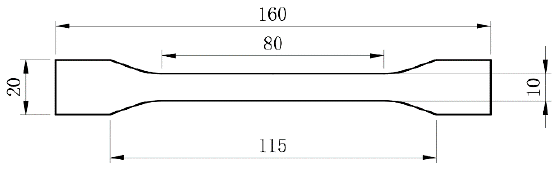
Figure 2. Sample geometry.